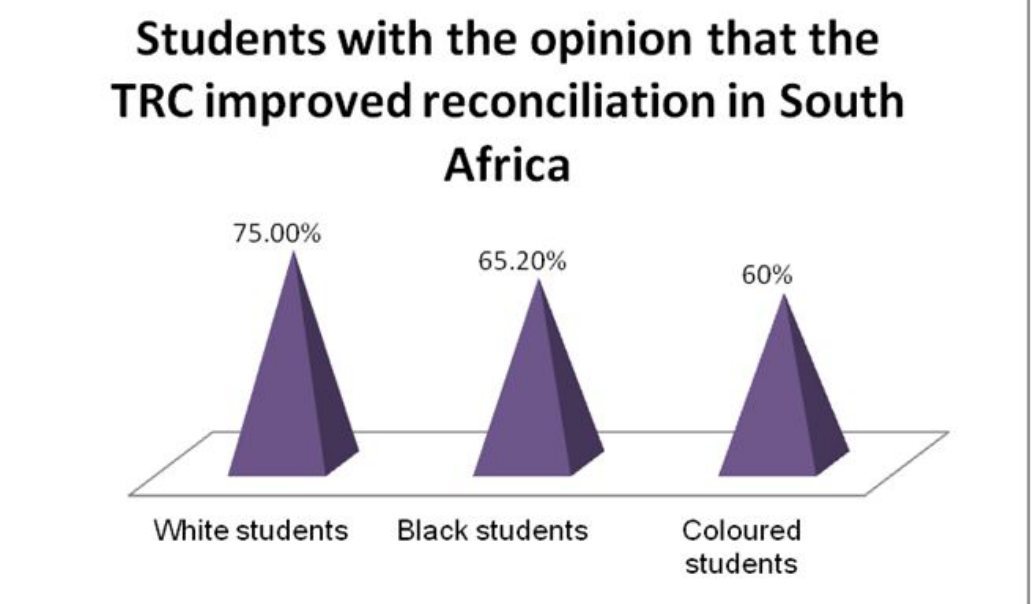
Figure 3: Percentage of students who agree that the TRC has improved reconciliation in South Africa